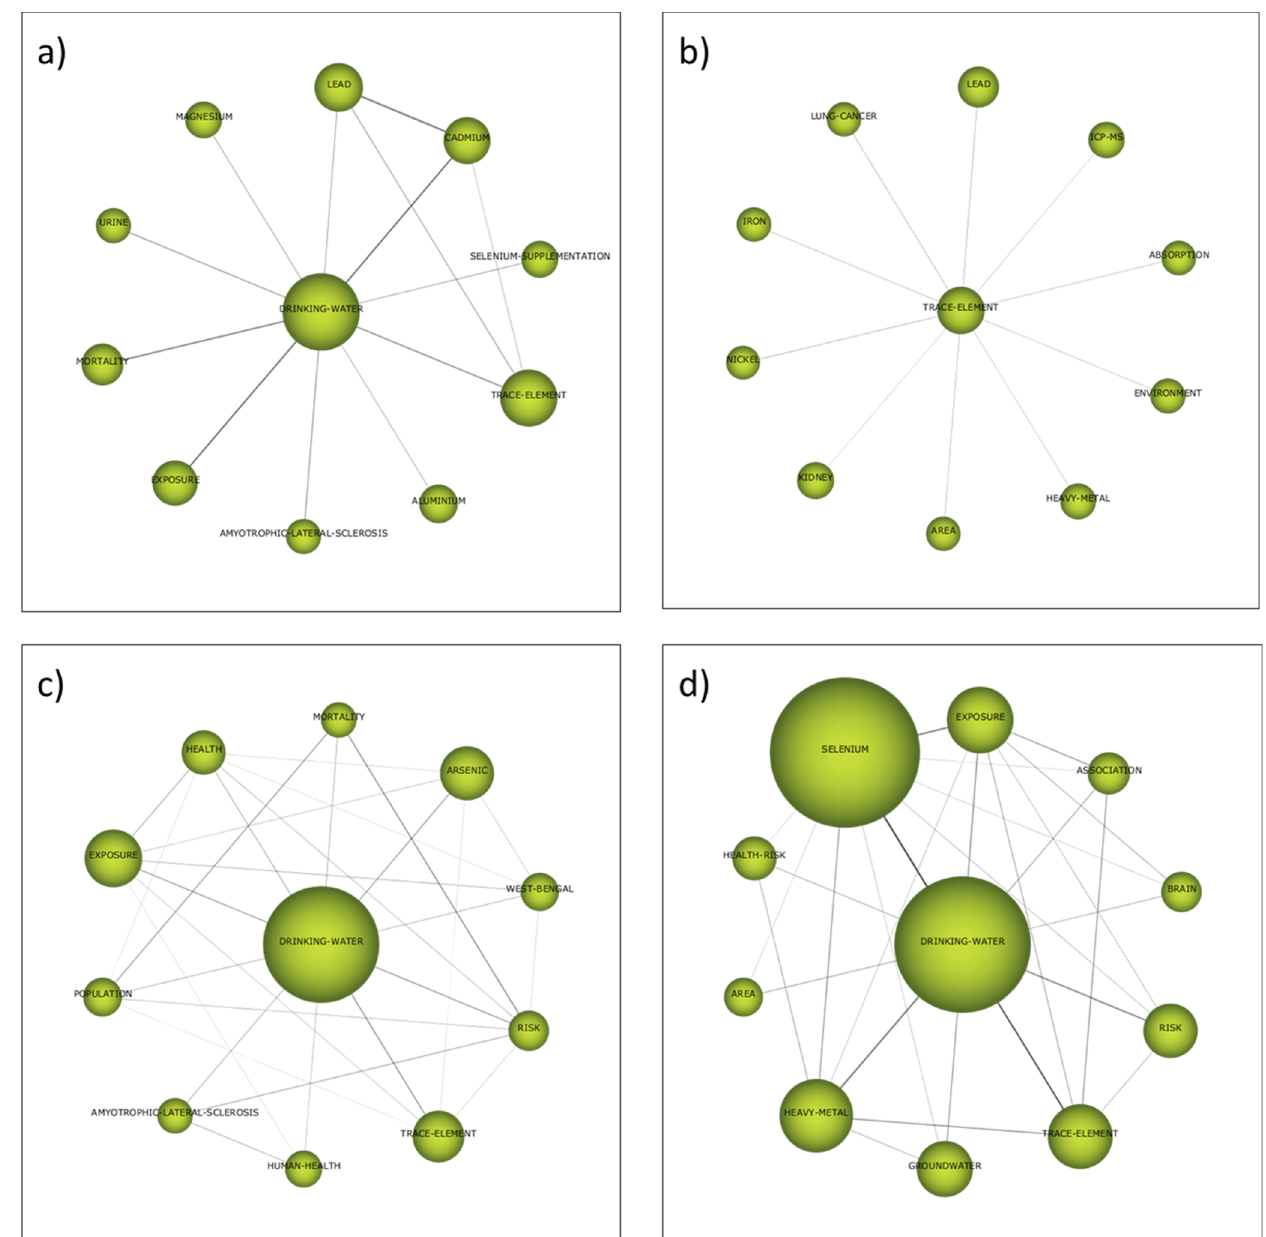
Figure 7. Evolution of the thematic network structure of the clusters Drinking-water/Trace-element : 1990–2001 ( a ), 2002–2011 ( b ), 2012–2019 ( c ) and 2020–2021 ( d ).